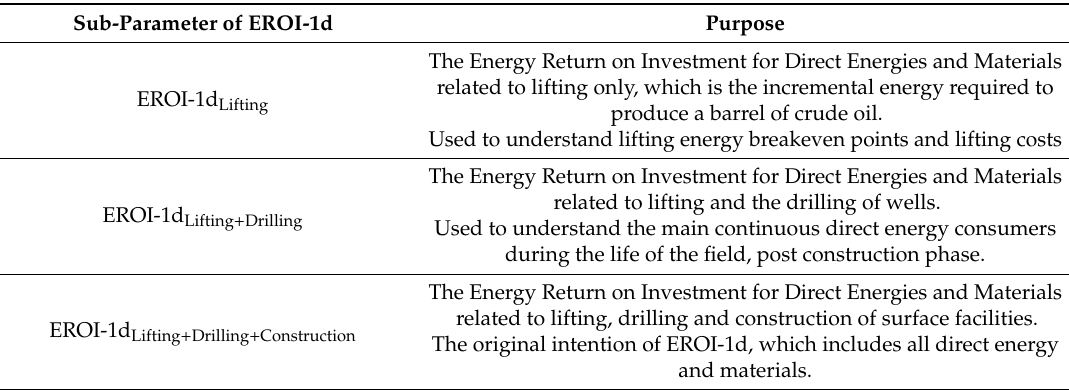
Table 2. EROI-1D